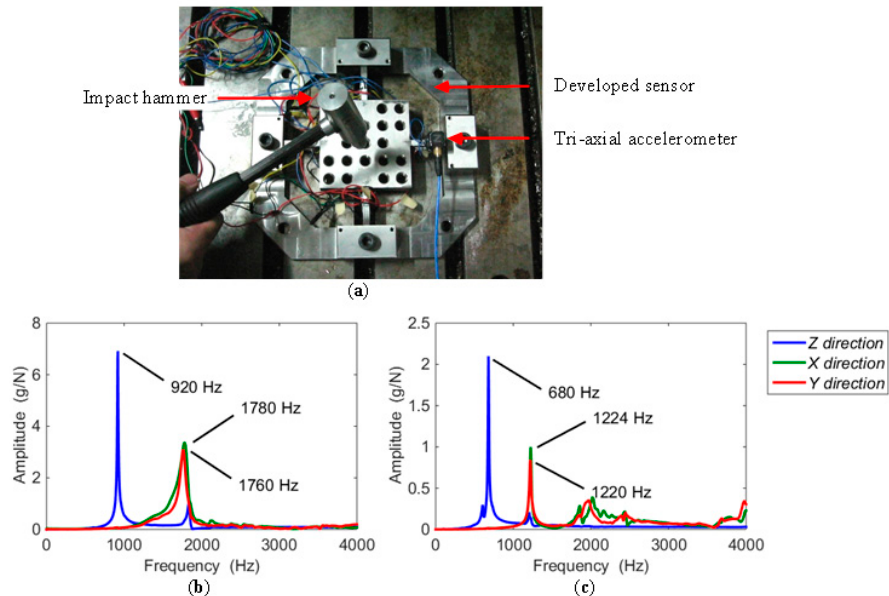
Figure 11. ( a ) Impact testing for the developed sensor; ( b ) frequency and amplitude results of sensor impact testing; ( c ) impact test results with a